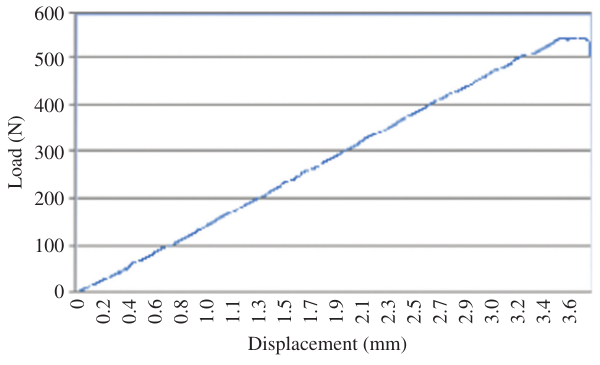
Figure 13 Load-displacement curve for [0 ° /90 ° /0 ° /90 ° /0 ° ] carbon/epoxy laminate in ENF test.